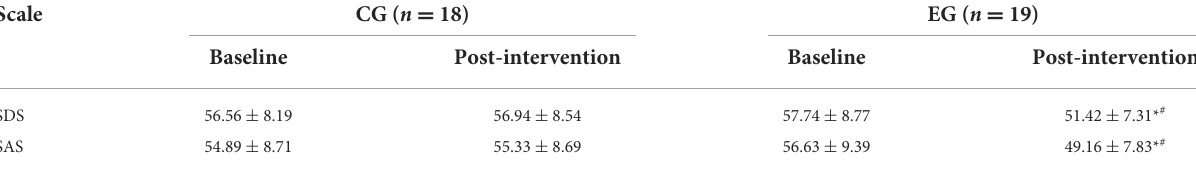
TABLE 4 The SDS and SAS scores of the CG and the